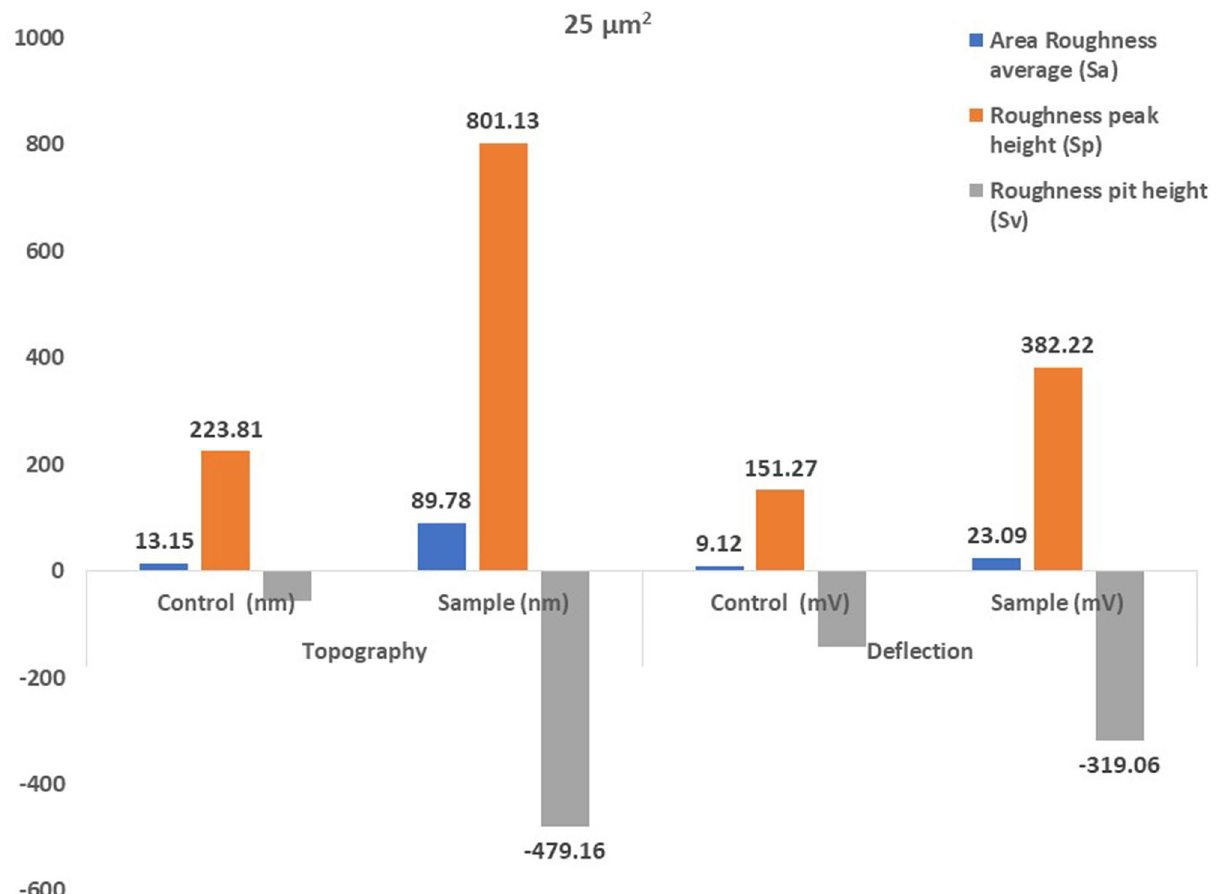
Figure 26. The bar graph showing differences in Area Roughness average (Sa), Roughness peak height (Sp), and Roughness pit height (Sv), comparatively between the control (untreated) and the U. africanum treated LDPE sheets of 25 µm 2